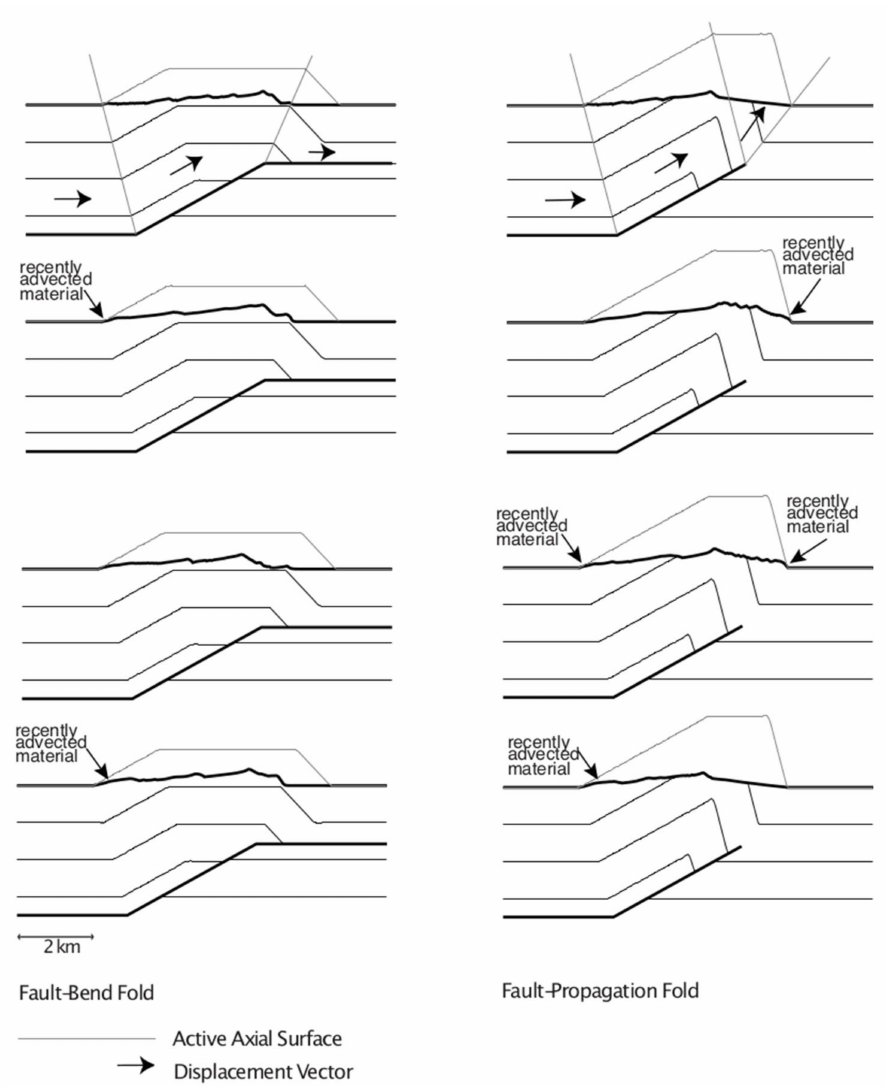
Figure 12. Serial sections of the fault-bend and fault-propagation folds taken at 2.5 km and 5 km north and south of the central section indicated in Figures 6 and 7. No vertical